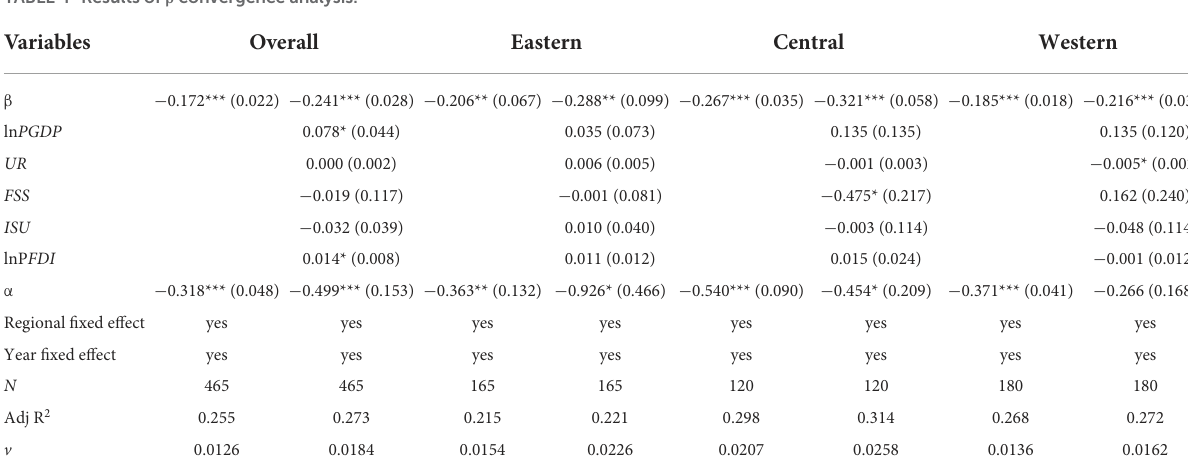
TABLE 4 Results of β convergence